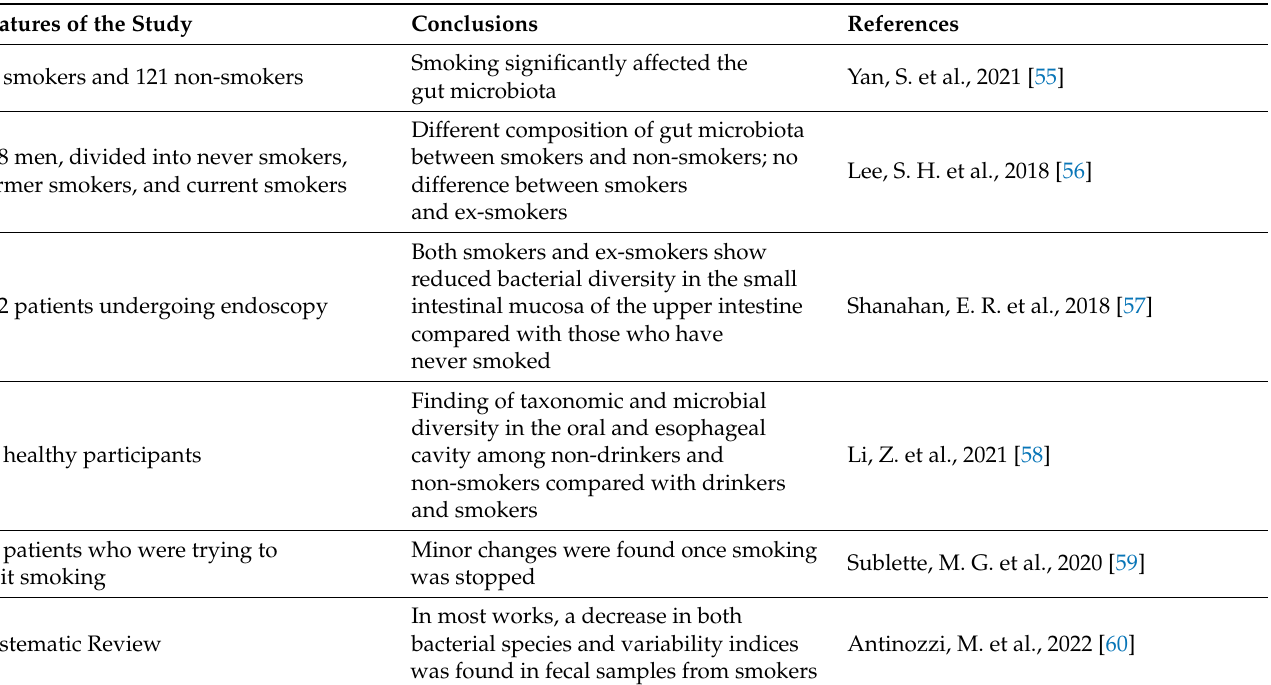
Table 5. Main studies conducted on the relationship between smoking and the gut microbiota